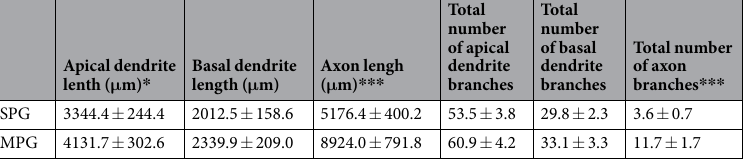
Table 2. Comparison of morphology measures between the SPG and the MPG. SPG: n = 39; MPG: n = 28. * Represents p - value < 0.05, *** represents p - value < 0.001 (two-tailed).